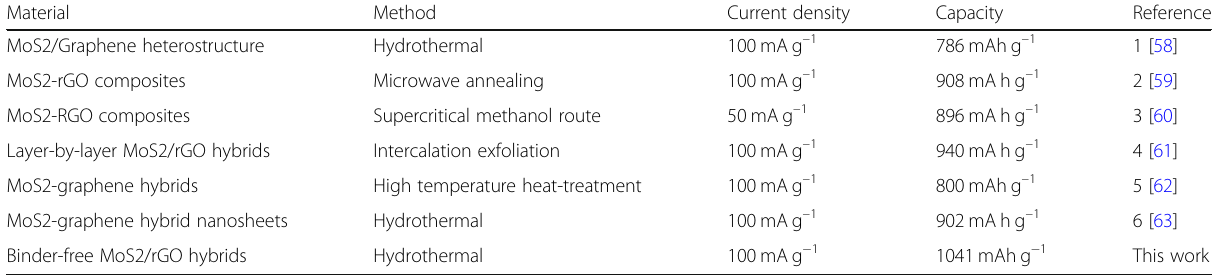
Table 1 Comparison of the capacity of MoS2-graphene composites materials for Li-ion Battery Material